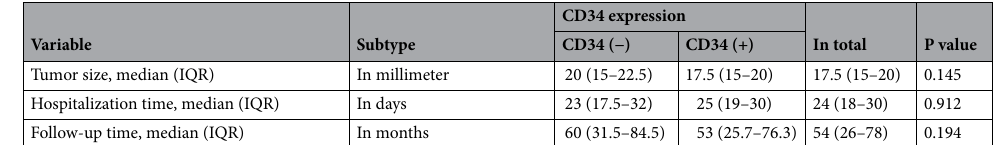
Table 1. Univariate analysis of the relationships between CD34 expression in GNT and clinicopathology in 247 patients. GG ganglioglioma, DNT dysembryoplastic neuroepithelial tumor, GNT glioneuronal tumor, GTCS generalized tonic–clonic seizure, SE status epilepticus, EEG electroencephalogram, FCD focal cortical dysplasia, HS hippocampus sclerosis, IQR interquartile range. a The unknown cases were those without detection of BRAF V600E mutation. b Patients with unknown results in lateral concordant EEG findings of interictal epileptiform discharges and of ictal seizure rhythms were recorded in 27 cases (no IEDs or normal EEG findings) and 80 cases (no ictus during video EEG monitoring), respectively. c P < 0.05, with